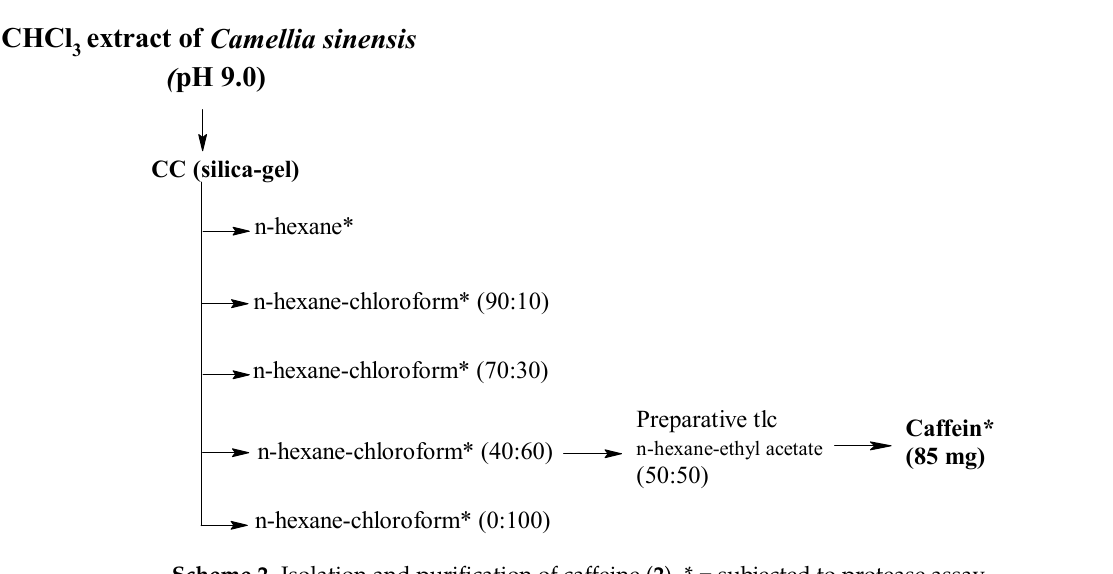
Table 4. Protease inhibition activity of the CC fractions of Camellia sinensis (pH